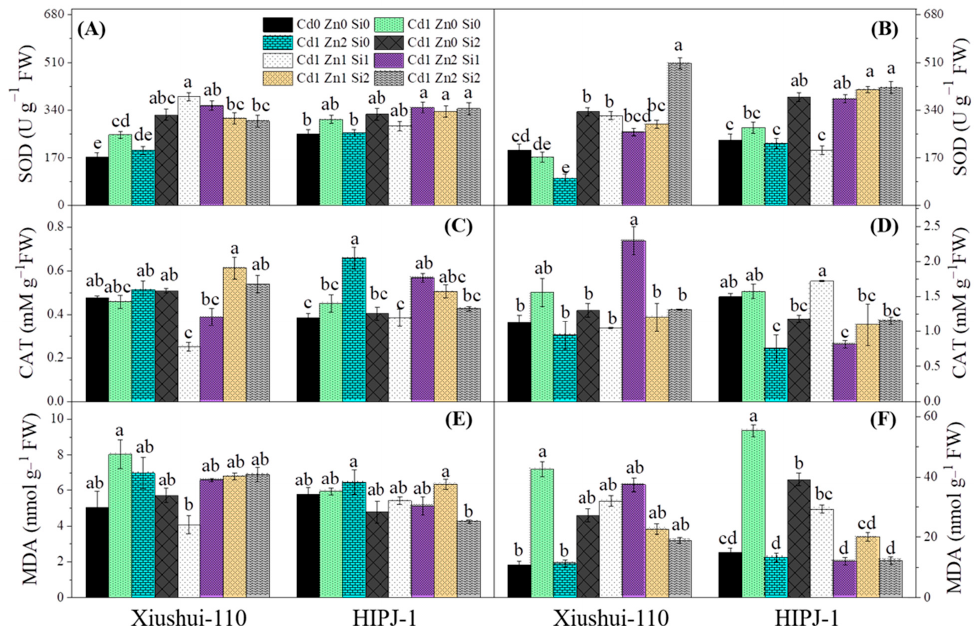
Figure 3. Effect of alone and combined stress of Cd, Zn, and Si application on antioxidant enzyme activities of superoxide dismutase (SOD) (( A ): Root, ( B ): Shoot), catalase (CAT) (( C ): Root, ( D ): Shoot) and malondialdehyde (MDA) contents (( E ): Root, ( F ): Shoot) of two rice genotypes. Legends: Cd0 Zn0 Si0 (CK). Cd0 (0 μ M), Cd1 (15 μ M); Zn0 (0 μ M), Zn1 (1 μ M), Zn2 (10 μ M); Si0 (0 μ M), Si1 (5 μ M), Si2 (15 μ M). Vertical bars represent the means of three independent replicates (±SE). Different letters indicate statistically significant differences at p ≤ 0.05 probability level within the genotype.